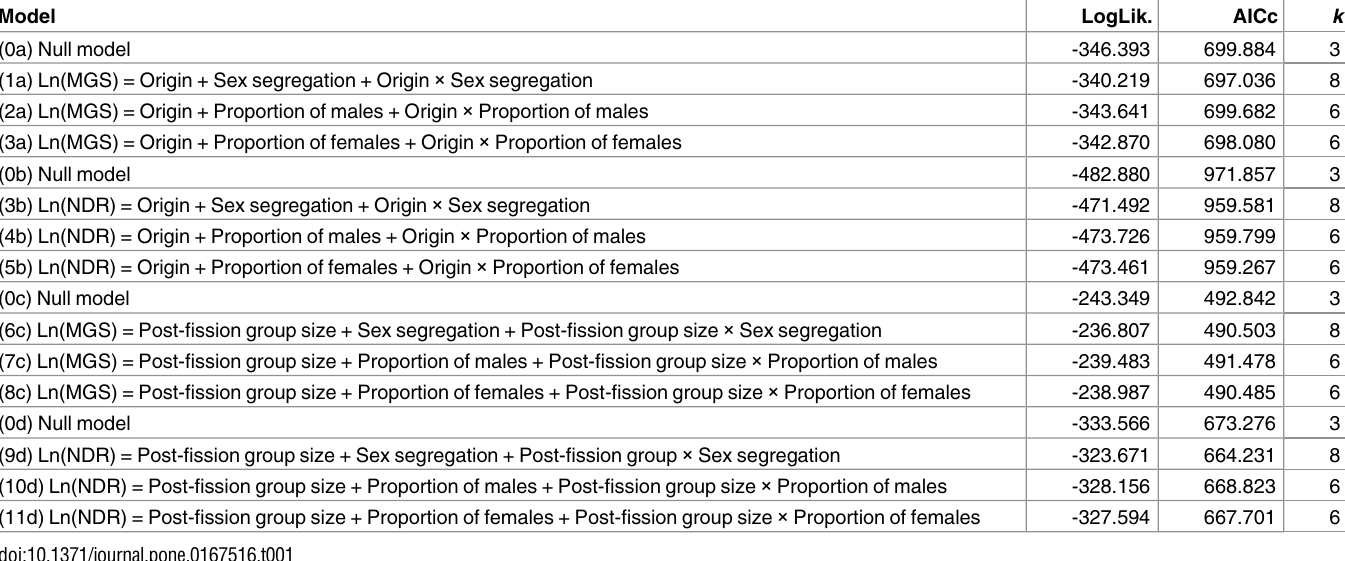
S1 Table for details of size and composition of initial, pre- and post-fission groups). Both the 95% confidence intervals of the large (5.20–6.03 individuals) and the small (1.48–2.31 individ- uals) included the values observed in the field. We studied 127 fission events; 86 of these (68%)